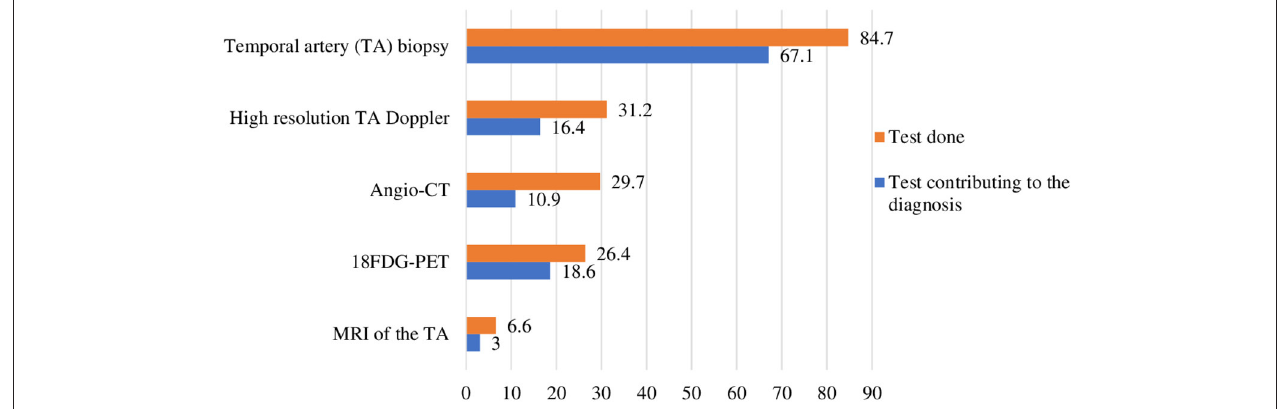
FIGURE 2 | Diagnostic tests for giant cell arteritis. Proportion of patients (%). CT, computed tomography; MRI, magnetic resonance imaging; 18 FDG-PET, 18 F-fluorodesoxyglucose positron emission